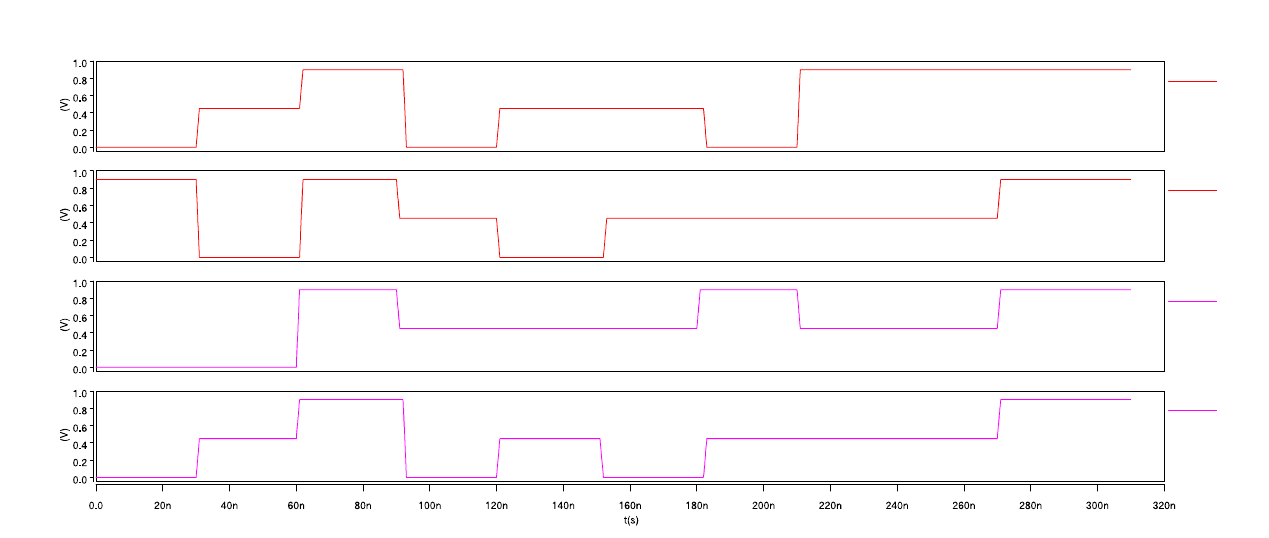
Figure 15. Input waveforms of 2-trit CNTFET-RRAM ternary multiplier module.